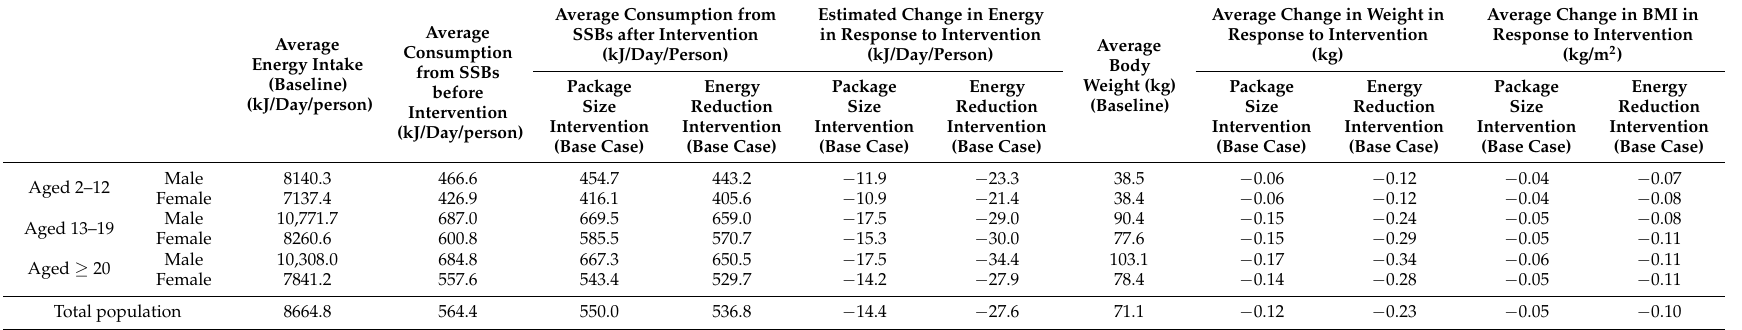
Table 4. Estimated effects of package size cap (base case) and energy reduction (base case) interventions on the 2010 Australian population over their lifetime.